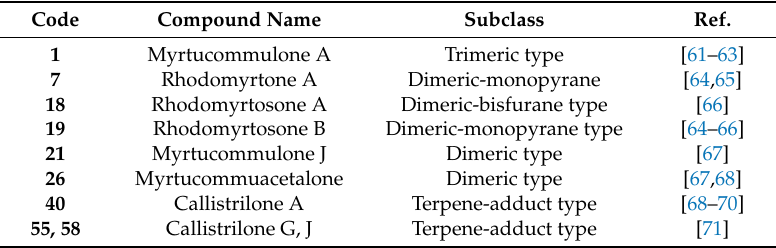
Table 2. Myrtucommulone-related compounds obtained